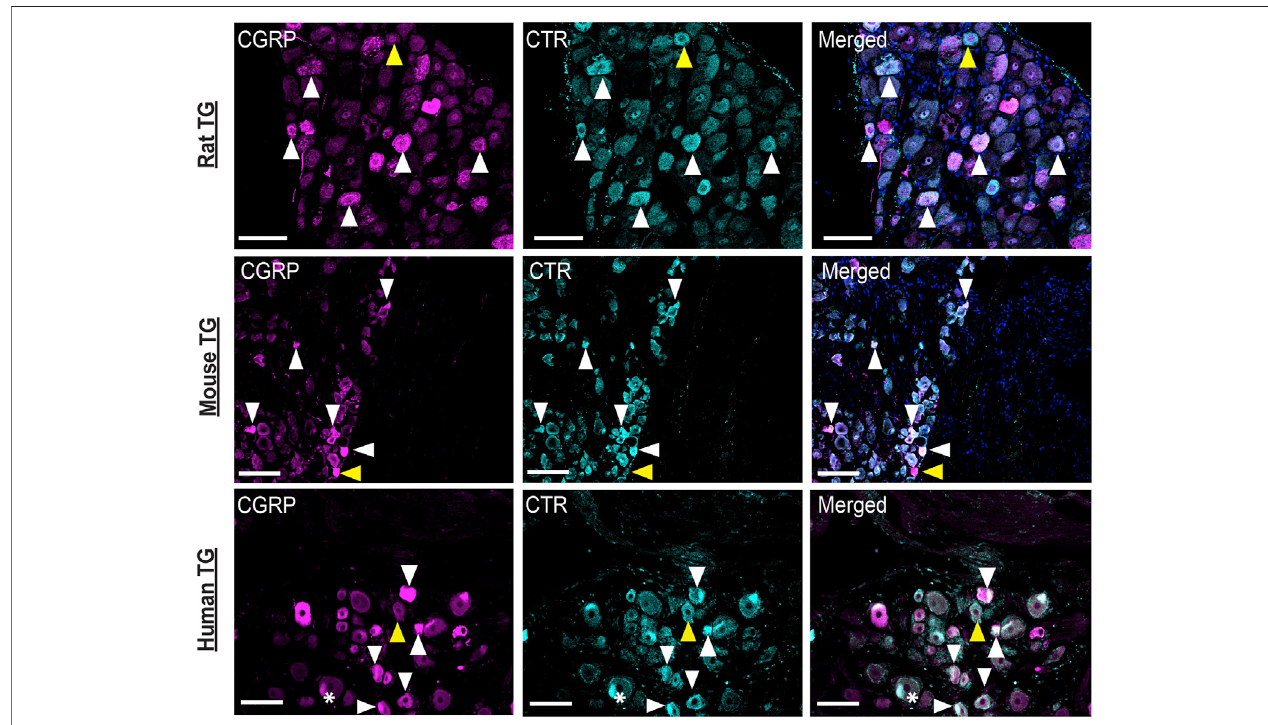
FIGURE 10 | Comparison of CGRP-like and CTR-like immunoreactivity across species. CGRP and CTR in rat, mouse and human TG. White arrowheads indicate colocalization; yellow arrowheads indicate expression in adjacent neurons. *Indicates examples of auto fl uorescence due to lipofuscin. Image brightness and contrast were adjusted for presentation purposes and merged in FIJI. Additional histogram adjustment (contrast stretching) was performed for these images to convey the frequency and variation in the intensity of the immunoreactivity. Scale bar = 100 μ m. Images are representative of six rats and mice (three male and three female). Human case 3A was used for this